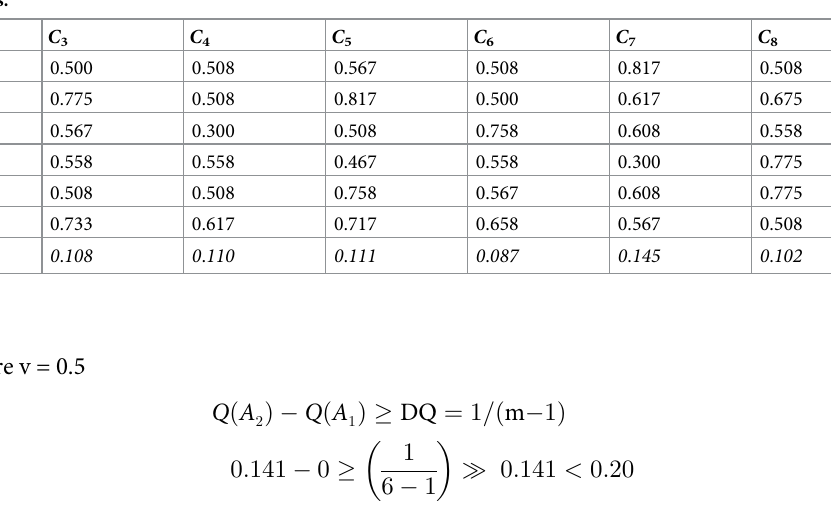
and negative ideal solutions f (cid:0) j